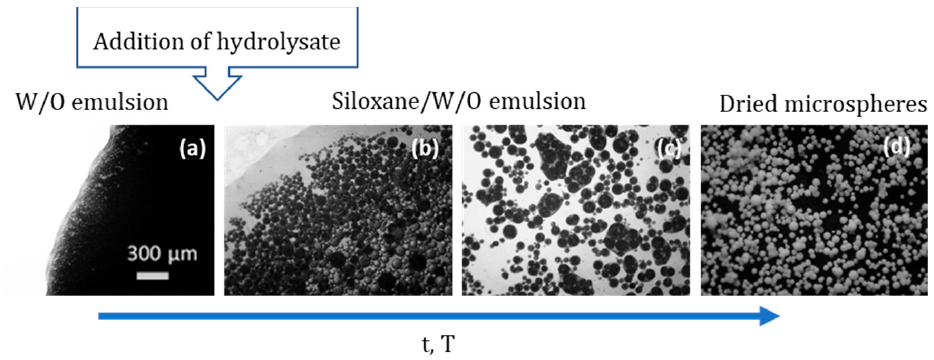
Figure 26. Optical microscopy photographs of reaction medium aliquots taken at different stages of the MICROSCAFS’ synthesis. ( a ) emulsion, ( b ) emulsion after addition of the hydrolysate, 1h at 65 °C, ( c ) after 1h at 80 °C, ( d ) epoxy functionalized silica-based porous microspheres dried at 40 °C. Bar scale = 300 µm ( a – d ). Photos acquired in transmission mode ( a – c ). Photo acquired in reflection mode ( d ) (A.C. Marques et al., unpublished results).